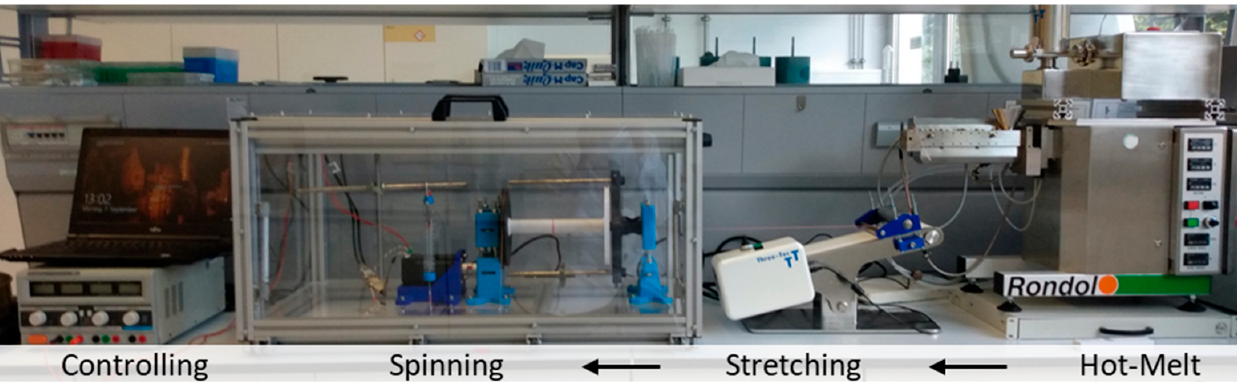
Figure 4. General configuration of the manufacturing setup for the production of pharmaceutical fibers and yarns. From right to left: Hot-melt-extrusion unit with feeding unit, modified table-top conveyor belt, spinning apparatus, power supply, and computer control of the line.